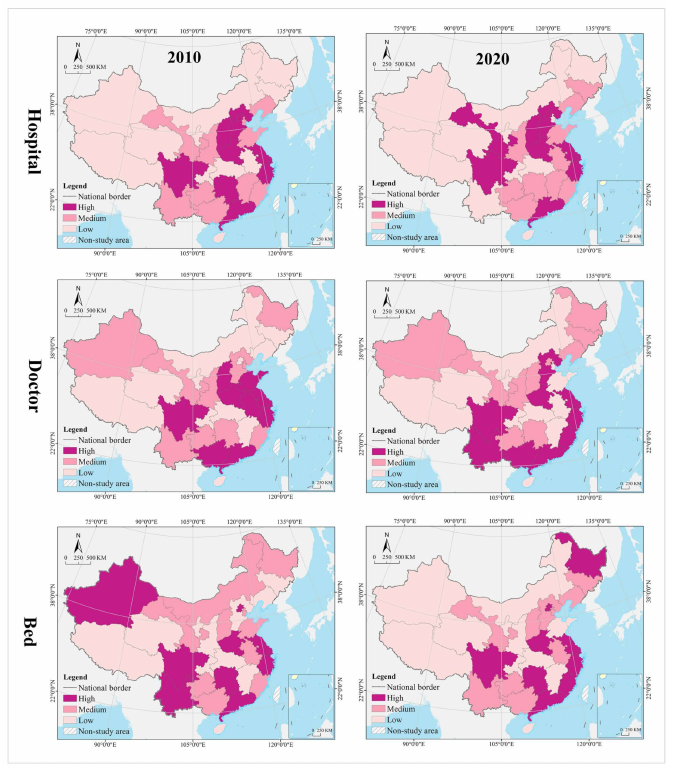
Figure 14. Spatial analysis of mismatch index contribution rate for